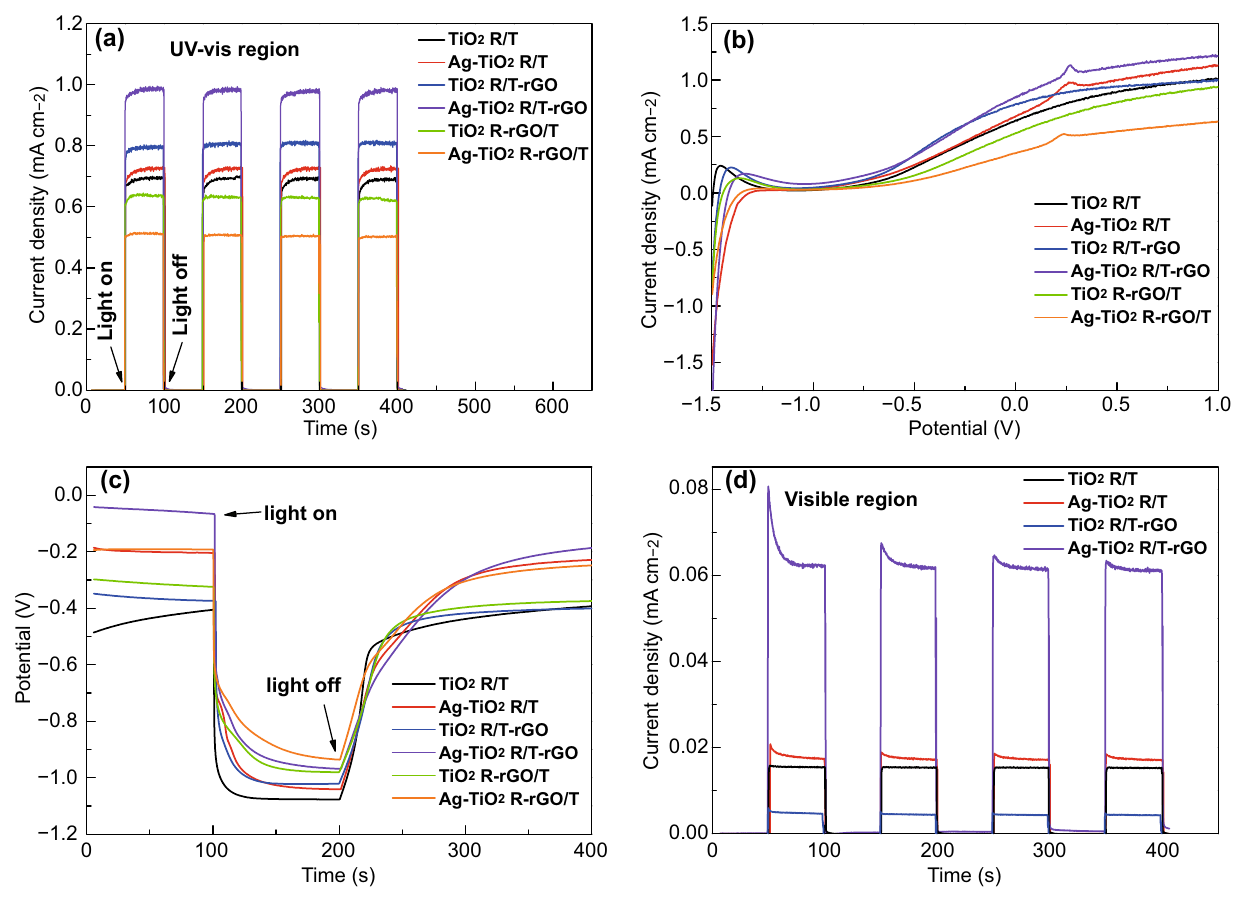
Fig. 8 a Photocurrent responses in the light on–off process under illumination of AM 1.5, b Linear sweep voltammetry, c open-circuit photovolt- age curves, and d photocurrent responses in the light on–off process under illumination of visible light ( λ > 400 nm) of TiO 2 -based nanomaterials